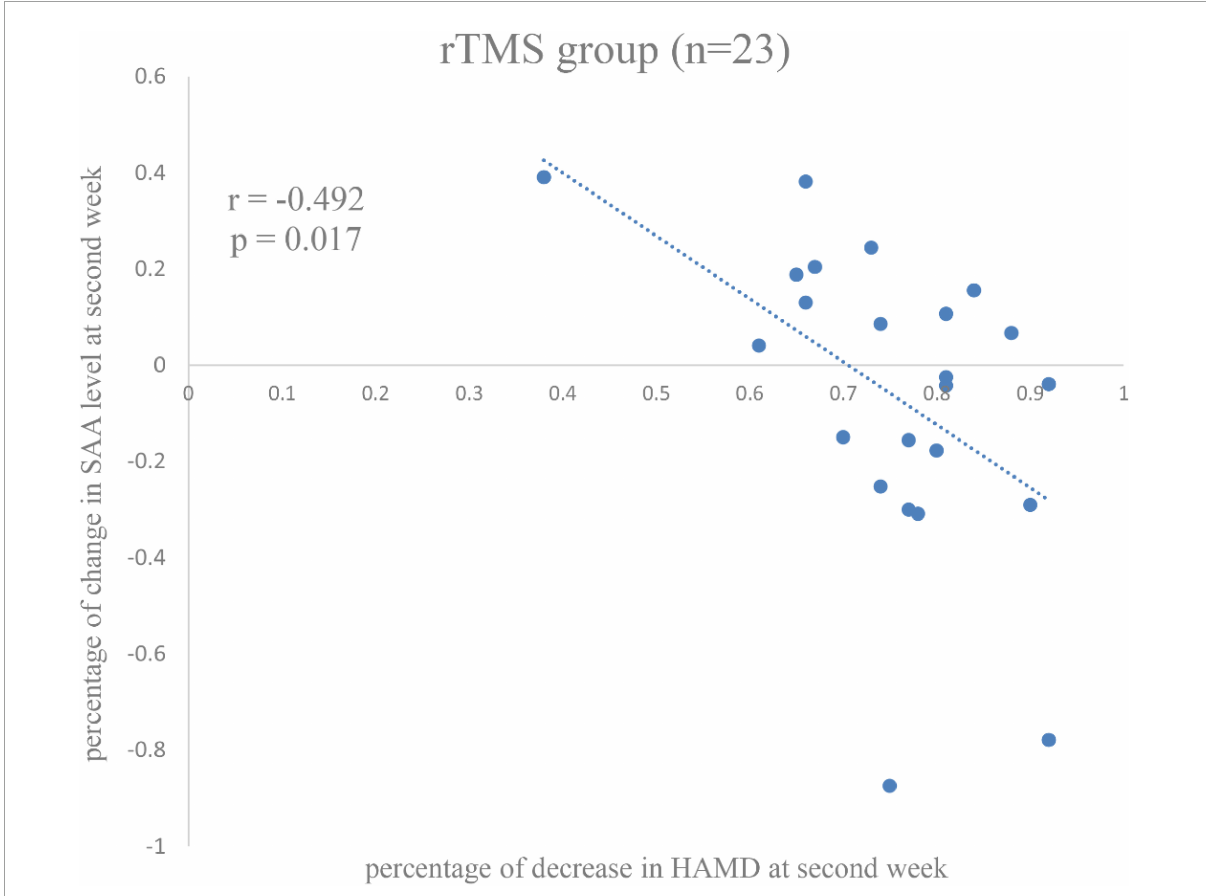
FIGURE4 Correlation between percentage of changes in serum amyloid A (SAA) level and percentage of decrease in Hamilton Rating Scale for Depression (HAMD) score in the repetitive transcranial magnetic stimulation (rTMS) group at the second week.